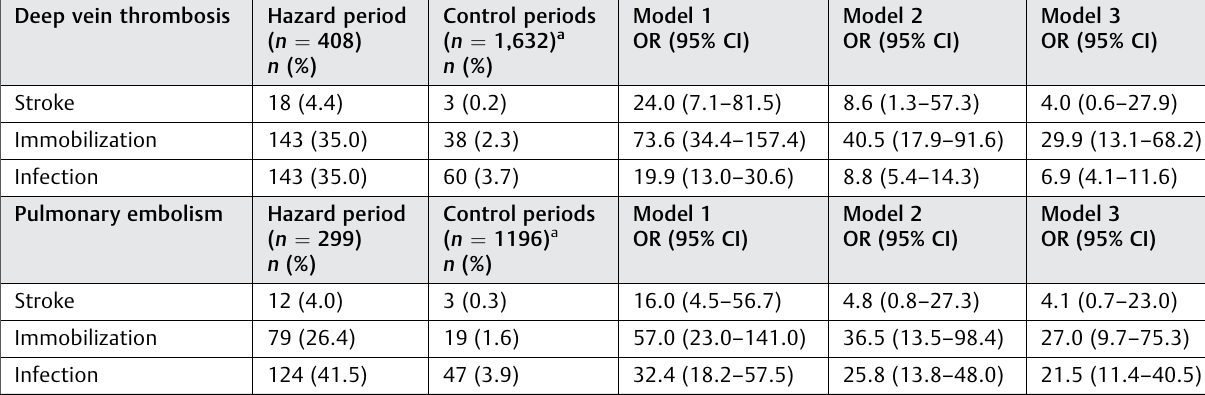
Table 3 Distribution of triggers in the hazard and control periods and odds ratios (ORs) of deep vein thrombosis and pulmonary embolism Deep vein